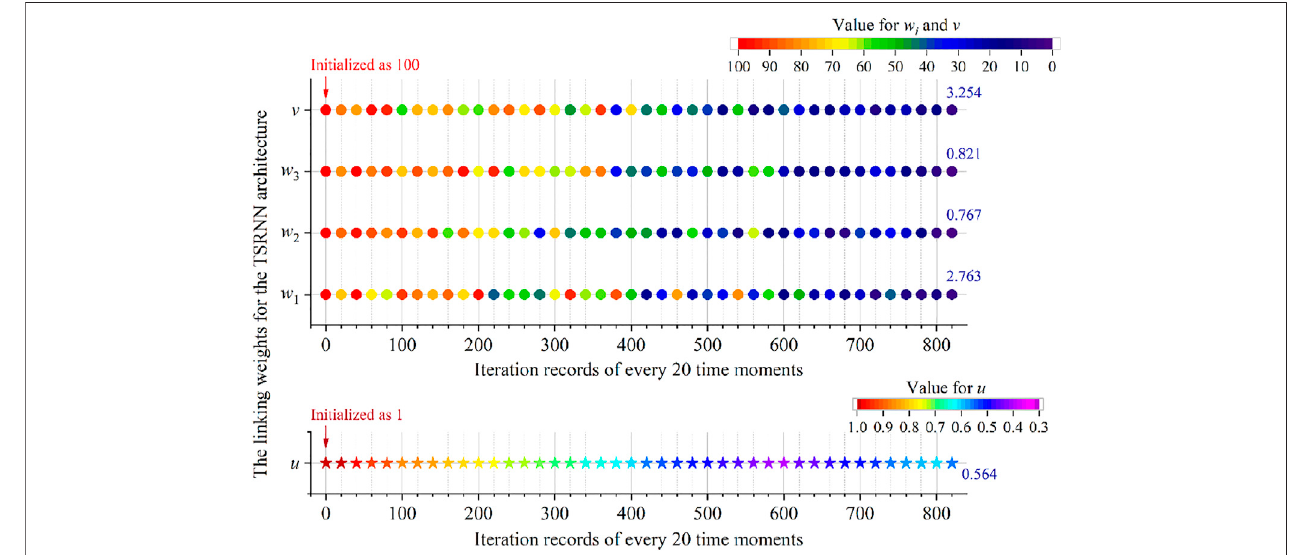
FIGURE 6 | Training of linking weights in the TSRNN structure.